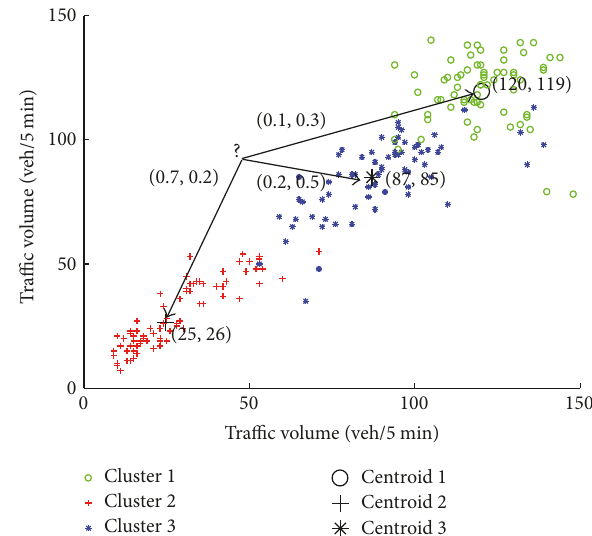
Figure 2: The process of FCM-based method for missing traffic data imputation.